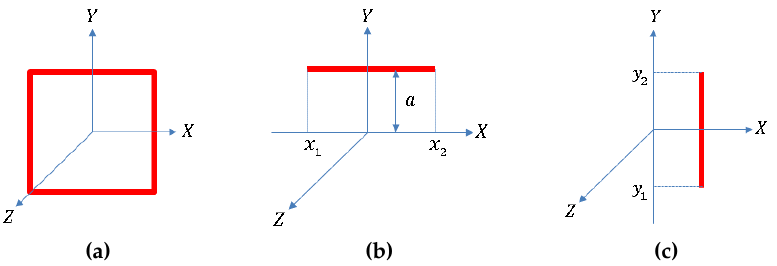
Figure 5. Magnetic flux calculation of a rectangular section of the coil: ( a ) a rectangular section of the coil with the coordinate axes; ( b ) horizontal section of the coil; ( c ) vertical section of the